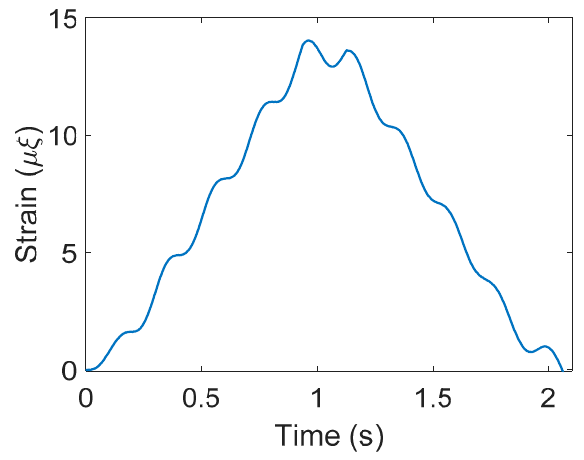
Appl. Sci. 2020 , 10 , x FOR PEER REVIEW Figure 3. Calculated strain signal at bridge mid-span. Figure 3. Calculated strain signal at bridge mid-span.